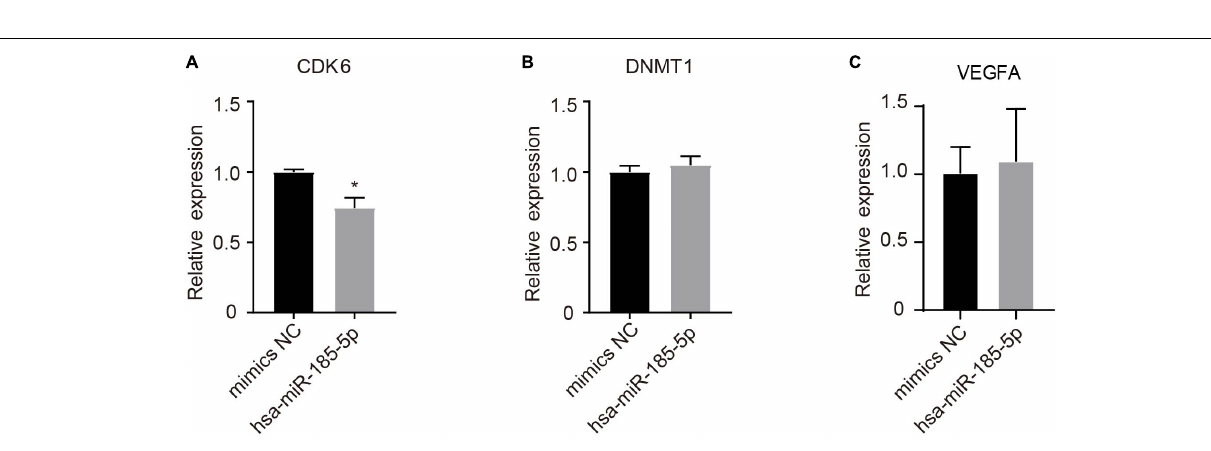
FIGURE 8 | Determination of potential target genes of hsa-185-5p in HUVECs. Cells were transfected with hsa-185-5p mimics or mimics negative control for 24 h. CDK6 (A) , DNMT1 (B) , and VEGFA (C) mRNA levels were determined using qRT-PCR. n = 3, * versus mimics NC, P < 0.05.